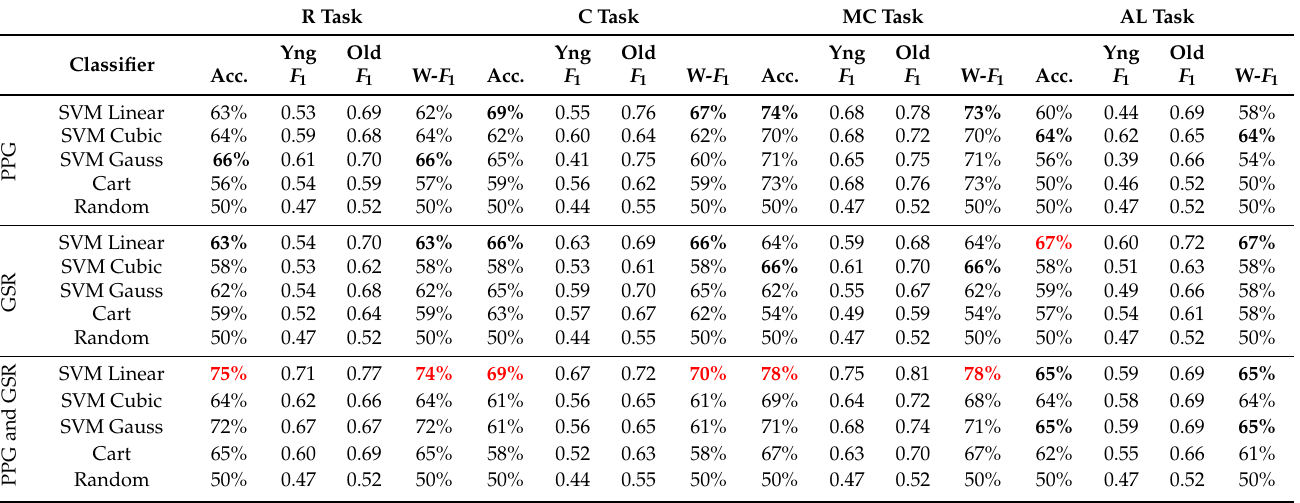
Table 2. Performance of the binary classifiers in discriminating young adults (Yng) from older adults (Old) in the different tasks analyzed, varying the feature set and adopting a LOSO validation strategy. Three performance metrics are reported: accuracy (Acc.), F1-score ( F 1 ) and weighted F1-score (W- F 1 ). In each table, the W- F 1 values in bold represent the best performances achieved for each feature set considered, while in red is highlighted the best accuracy at all. The analyzed tasks have been referred according to the following coding: R = reading task, C = comprehension task, MC = math calculation task, AL = audio listening